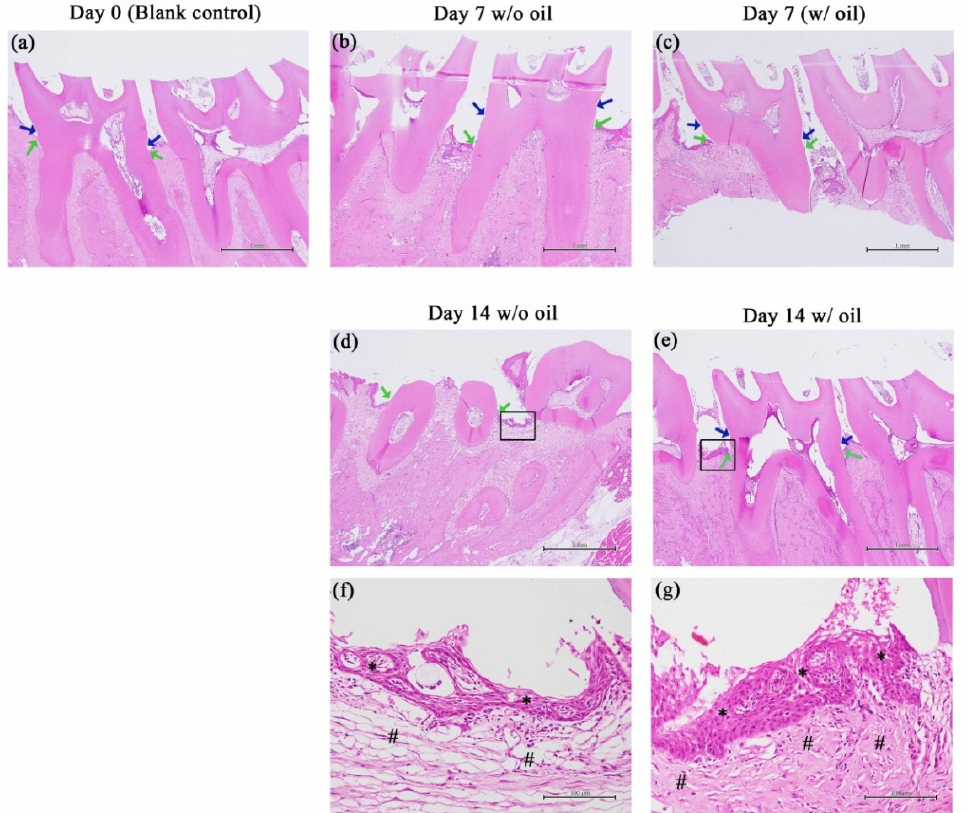
Figure 3. Histological results of tested molars at Day 0 ( a ), Day 7 ( b , c ) and Day 14 ( d , e ) with a magnification of 40 × . Images of bone-surrounding tissue interface (black box) of oil-treated ( d ) and oil-free ( e ) samples on Day14 were enhanced by higher magnification micrographs of 400 × ( f , g , respectively). Blue arrows indicate cemento-enamel junction (CEJ). Green arrows indicate the most coronal level of the alveolar bone crest (ABC). * and # signs identify the epithelium and lamina propria, respectively. Scale bar is 1 mm for ( a – c ), and 100 µ m for ( f , g ).